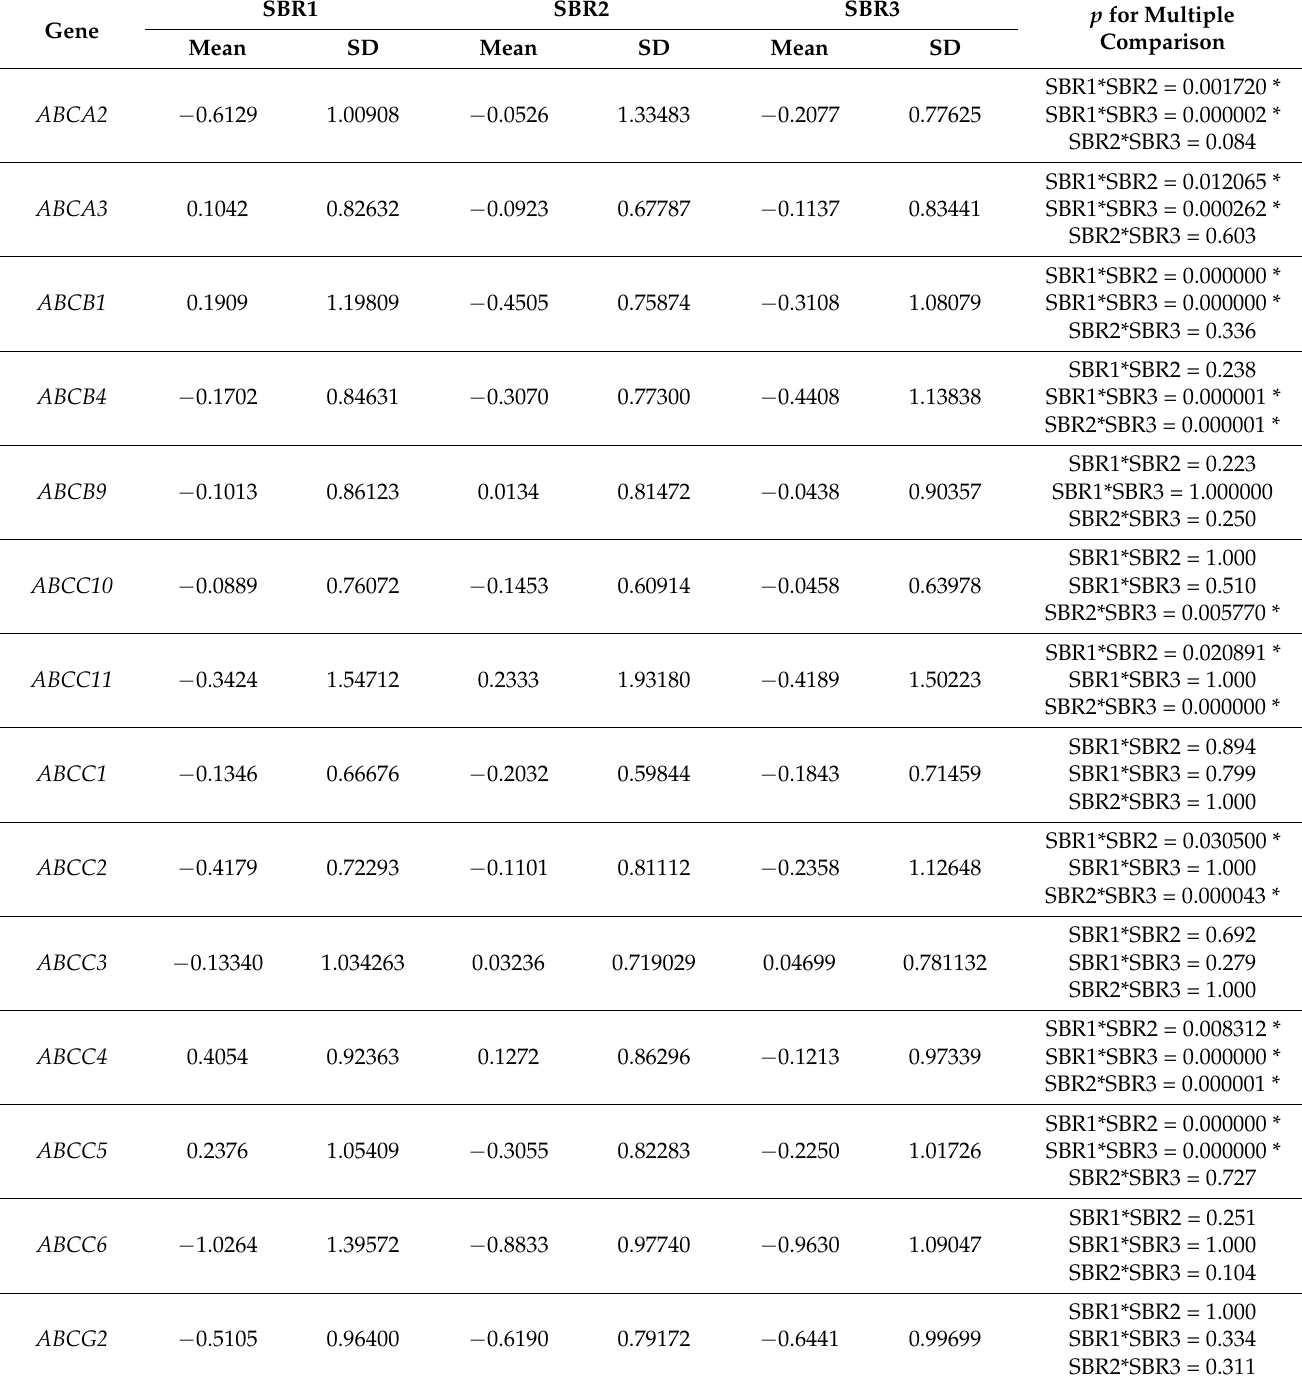
Table 2. Levels of statistically significant differences in the expression of the examined genes in patients classified into the SBR1, SBR2, and SBR3 groups (H Kruskal–Wallis test with multiple comparison) and descriptive statistics. Statistically significant values are marked with